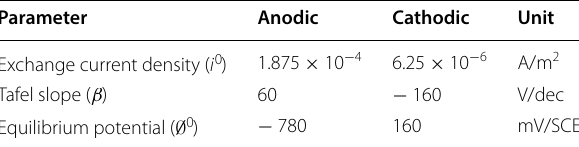
Table 3 Polarization data used in the model has been adopted from works of Kranc and Sagues